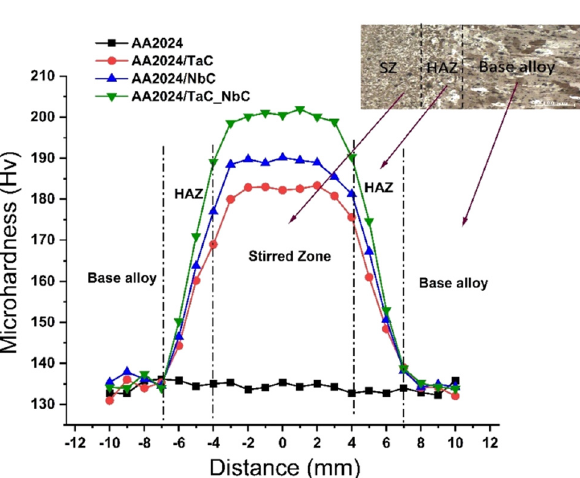
Figure 14. The base alloy averaged 132.5 HV0.1, as can